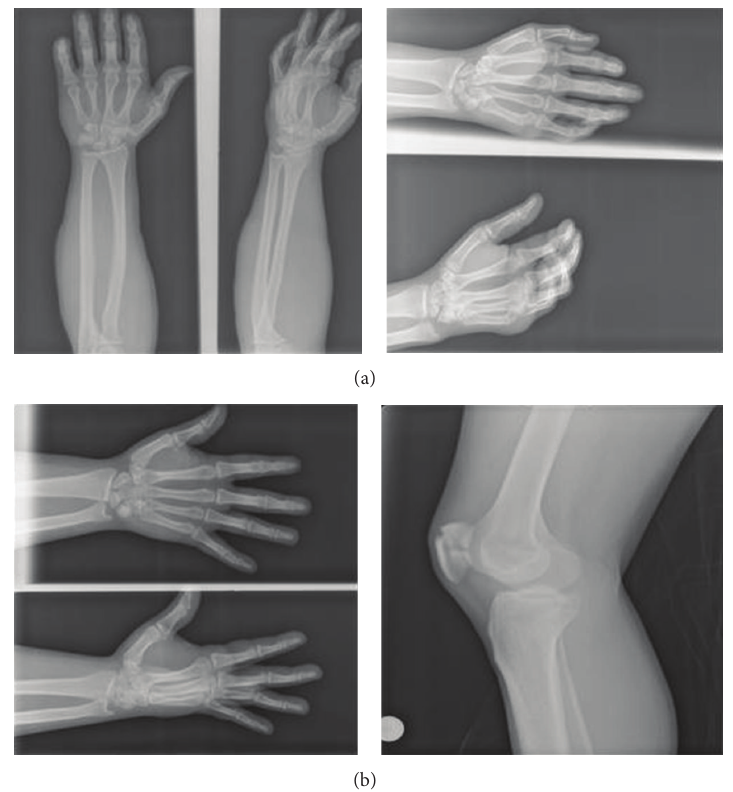
Figure 3: (a) Training Set. (b) Testing Set.